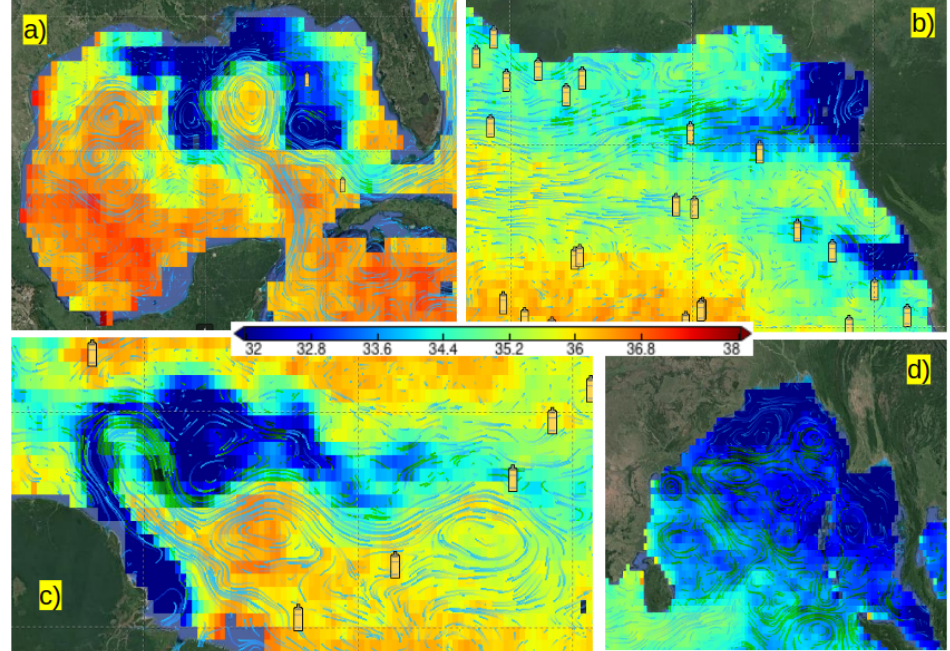
Figure 18. Illustration of the river plumes using Syntool: ( a ) Mississippi, ( b ) Congo/Niger, ( c ) Ama- zon/Orinoco, and ( d ) Ganges and Brahmaputra rivers. Colors correspond to SSS data coming from different satellite products available in the portal. The streamlines represent the geostrophic currents and the yellow bottles icons in ( a – c ) indicate Argo floats